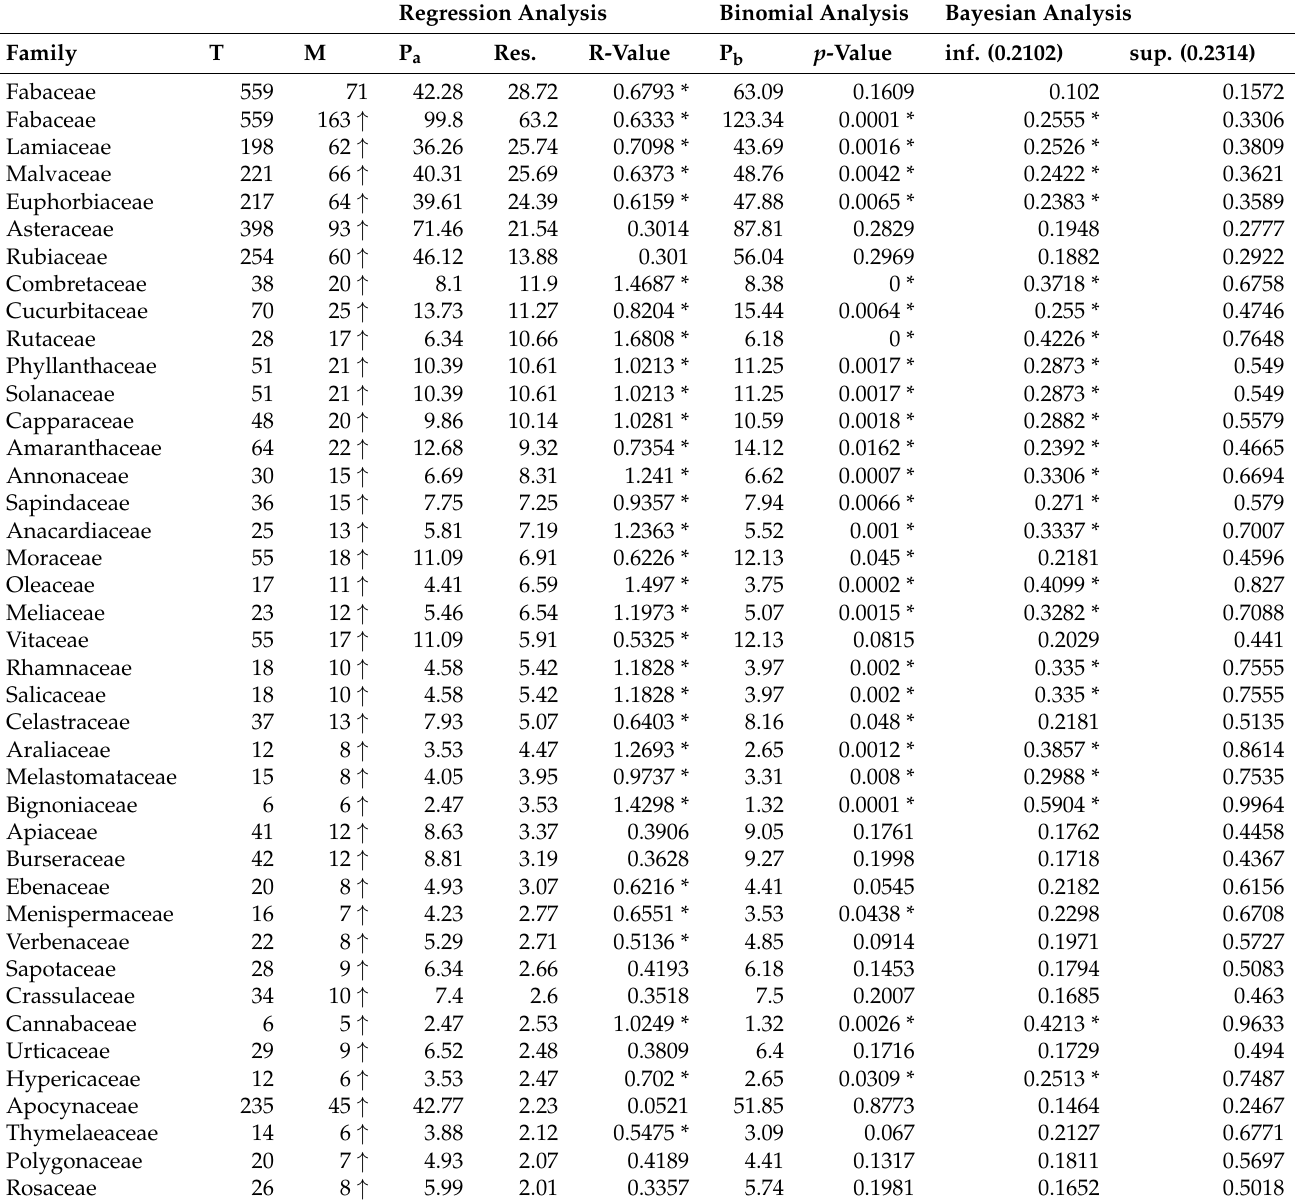
Table 2. Quantitative analysis of medicinal species in families. T—total number of species in the flora; M—medicinal species; P a —predicted medicinal species under the regression model; ↑ / ↓ —positive/negative outliers based on residuals; Res.—regression residuals; P b — predicted medicinal species under binomial model; inf.—Bayesian inferior 95% probability credible intervals; sup.—Bayesian superior 95% probability credible intervals; *—positive